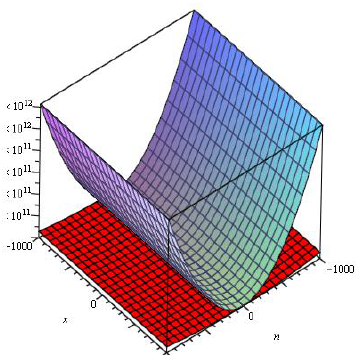
Fig. 6 The red and blue sheets show the comparison result for hyper Revan index of first and second kind Isocahedral network IS n